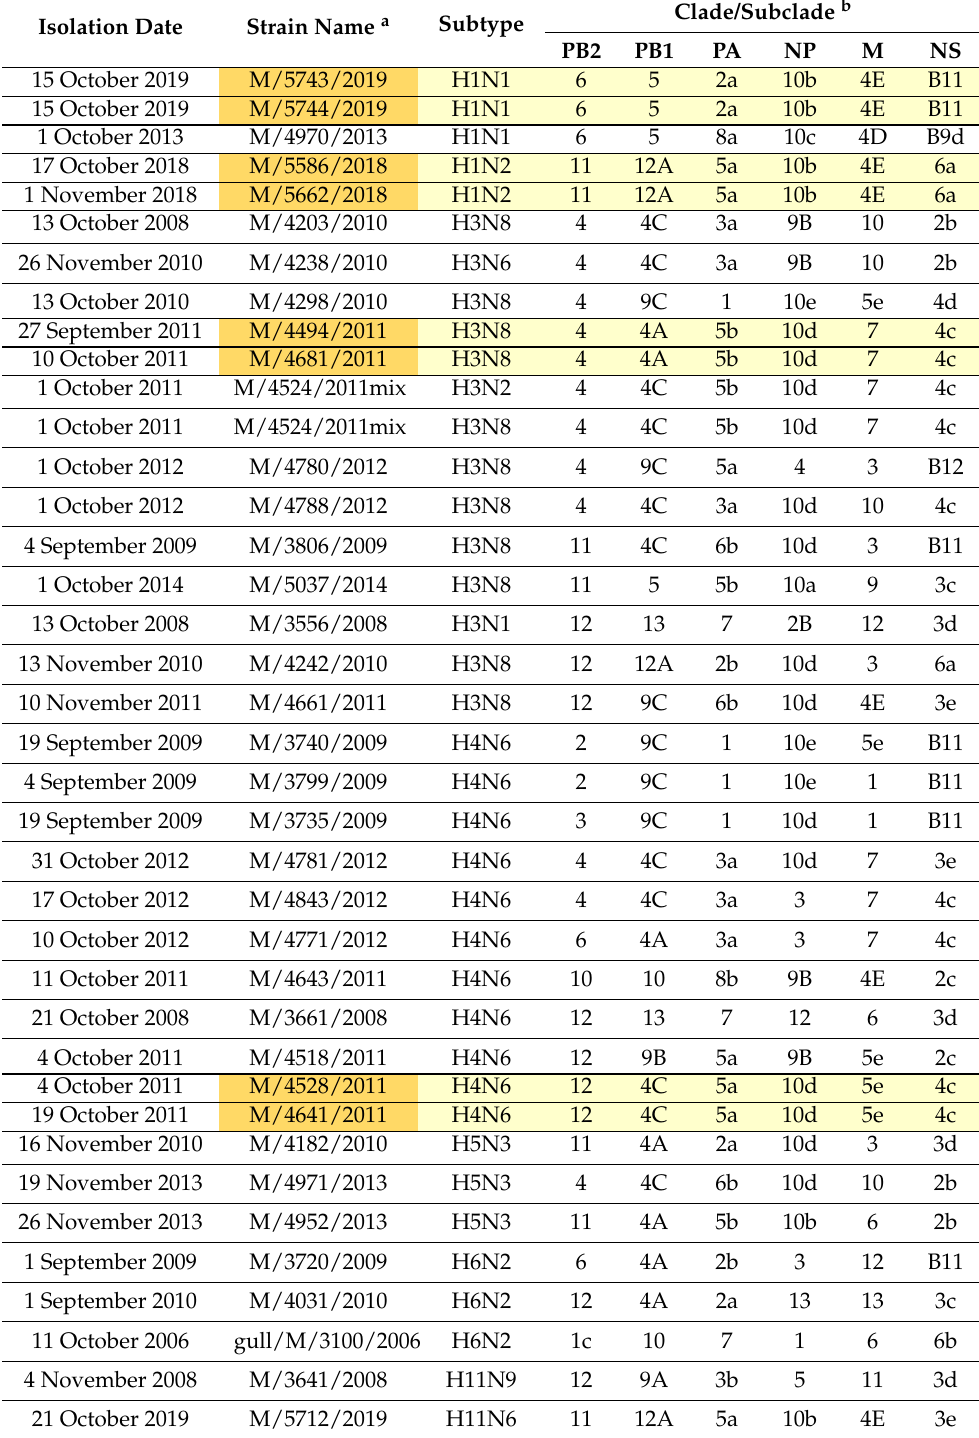
Table 1. Clades and subclades of the gene segments of IAVs isolated in